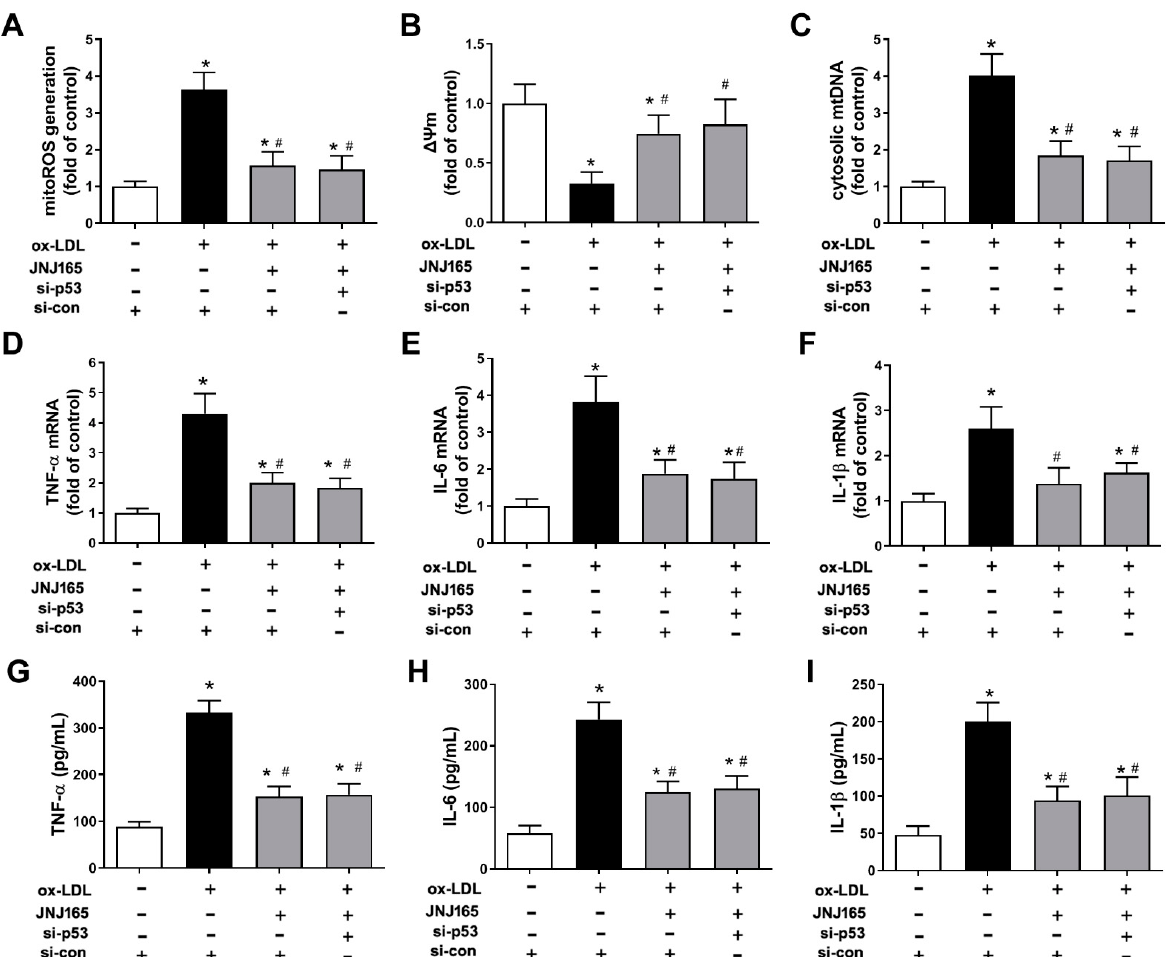
Figure 7. MDM2 inhibitor JNJ-165 provides protection against ox-LDL-induced mitochondrial damage and related inflammation independent of p53. For ( A – I ), HAECs were transfected with p53 siRNA (si-p53) or si-con for 24 h and then treated with or without JNJ-165 (10 μ M). After 1 h, the cells were stimulated with 100 μ g/mL ox-LDL for an additional 24 h. ( A ) mitoROS. ( B ) ΔΨ m. ( C ) mtDNA. ( D – F ) The mRNA expression of TNF- α ( D ), IL-6 ( E ) and IL-1 β ( F ). ( G – I ) The secretion of TNF- α ( G ), IL-6 ( H ) and IL-1 β ( I ). Results are presented as the mean ± SD. n = 6. * p < 0.05 vs. si-con with no treatment, # p < 0.05 vs. ox-LDL + si-con group.